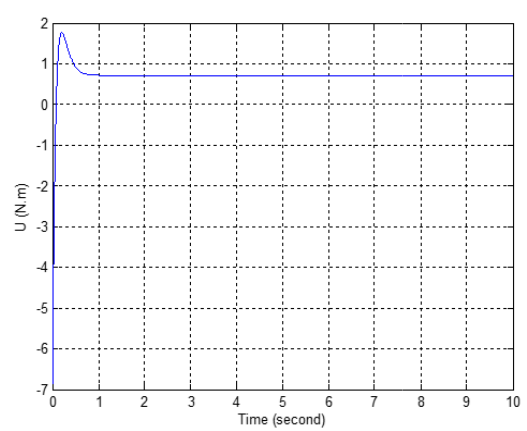
Fig. 28. The plot of the Sliding variable The plot of the Sliding variable f and the Integral term g vs. time of the ISMC. vs. time of the